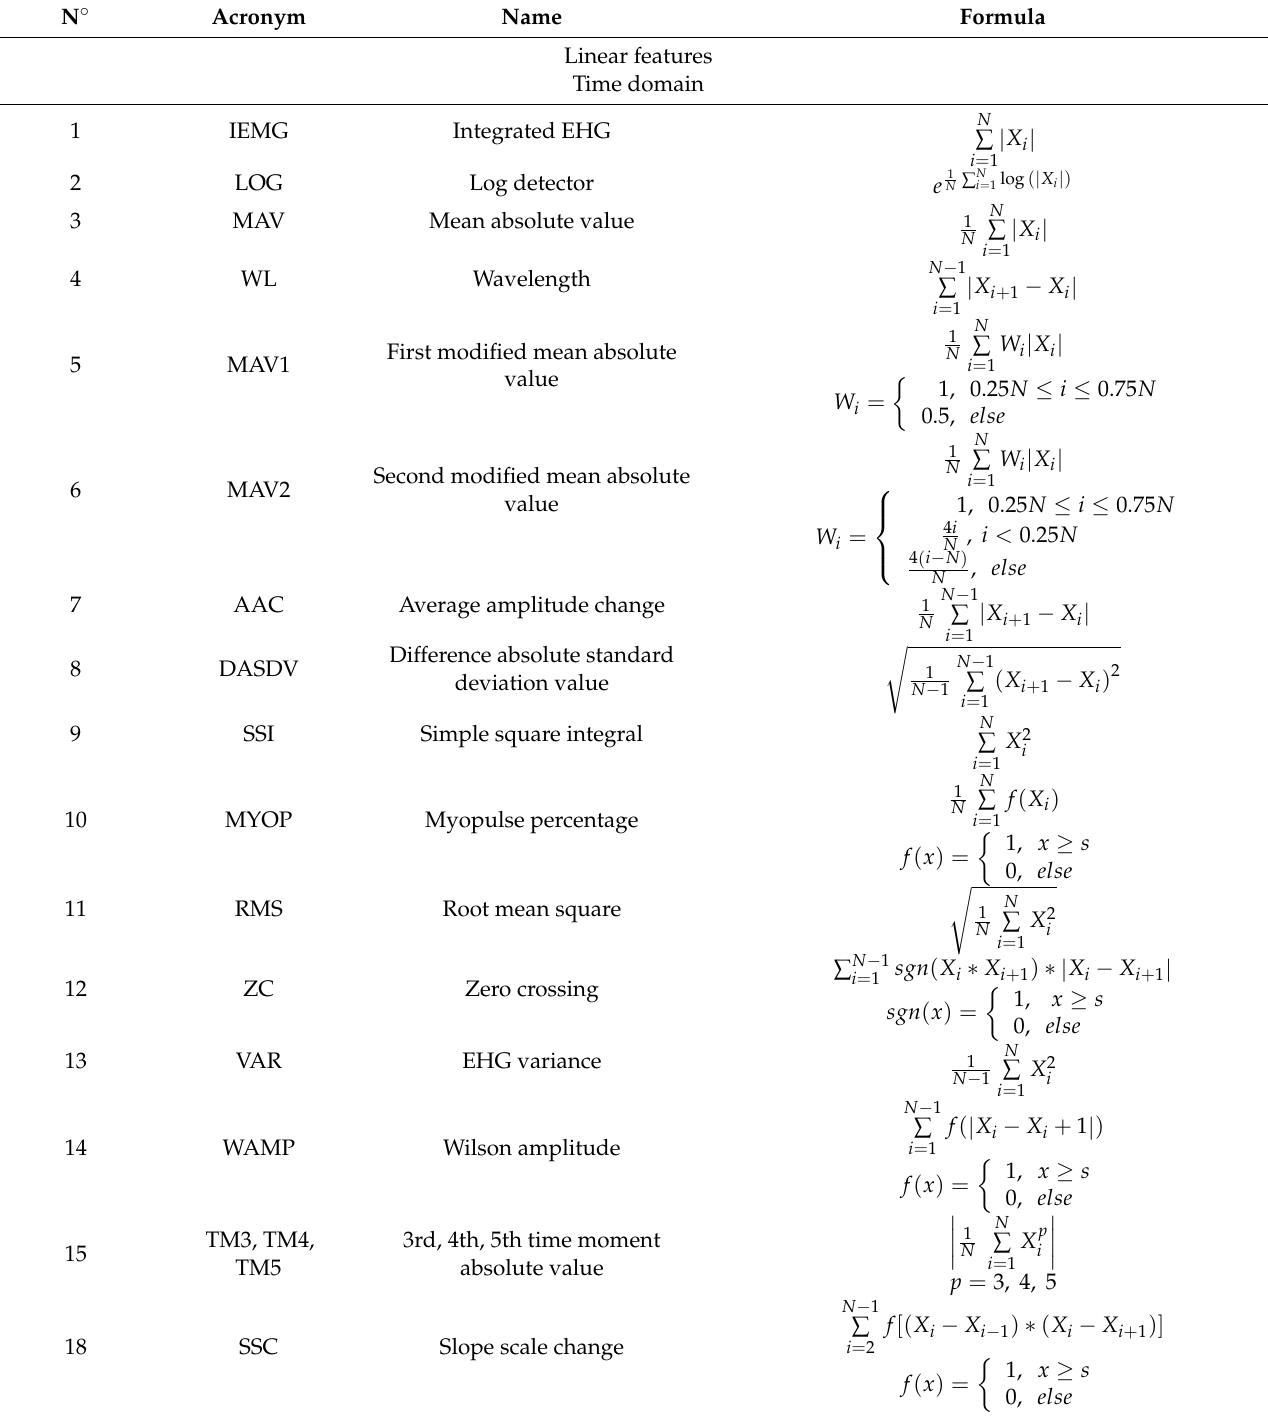
Table A1. Summary of the 30 most frequently used parameters in the literature